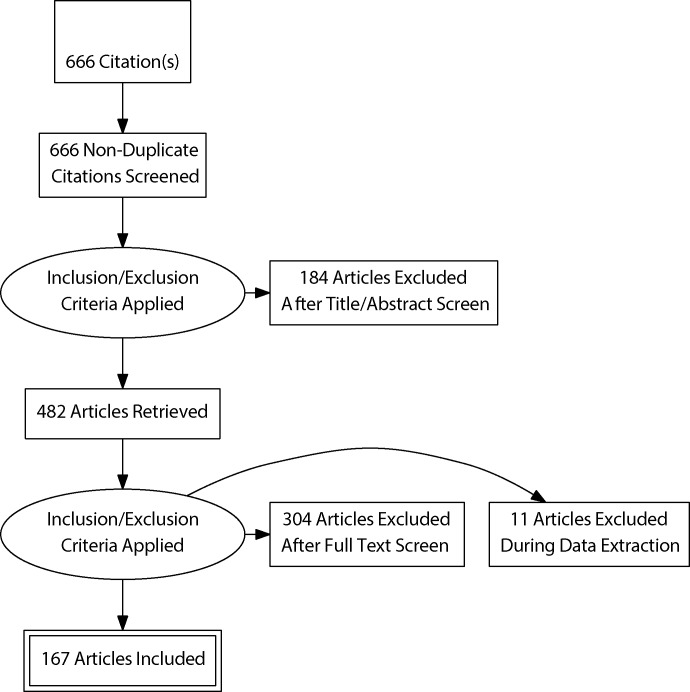
PRISMA flowchart.